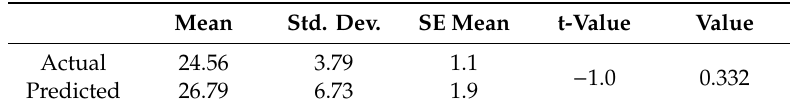
Table 1. Summary of two-tailed